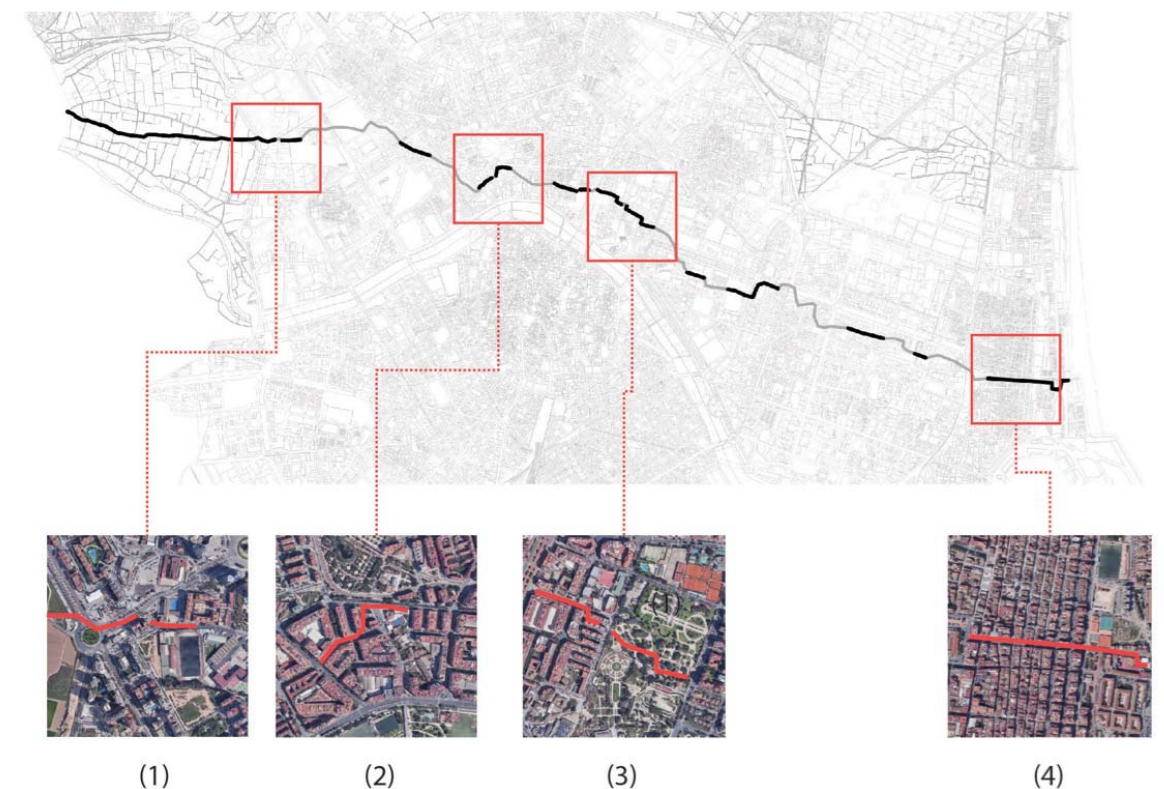
Figure 15. The inheritance of the irrigation canals in urban spatial structure and satellite images showing the type of land configuration in relationship with canal layout. ( 1 ) The inheritance located between urbanized area and cultivation area. ( 2 ) The inheritance located in urbanized area. ( 3 ) The inheritance located between building block and urban green. ( 4 ) The inheritance located in the historic settlement.